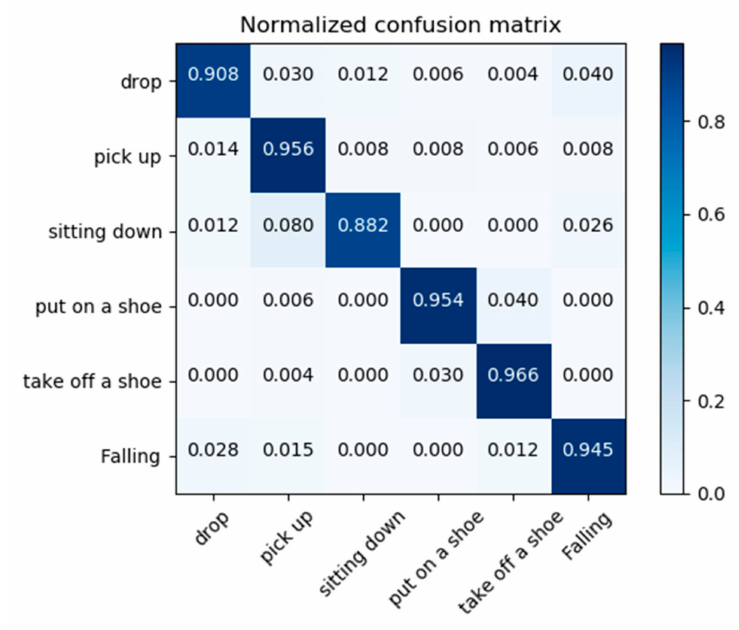
Figure 5. Confusion matrix for falls and similar actions on the collected NTU dataset.